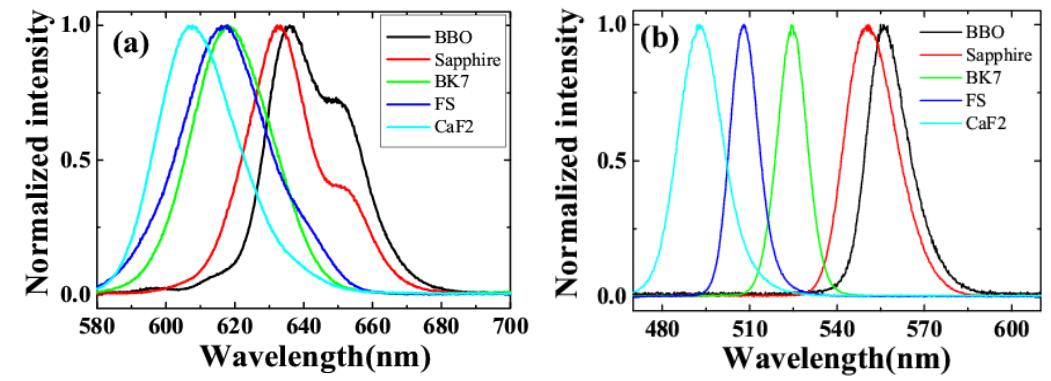
Figure 6. Spectra of (a) the AS1 sideband (c) the AS3 sideband of CaF sapphire plate, and BBO crystal at 1.8º crossing angle [33].